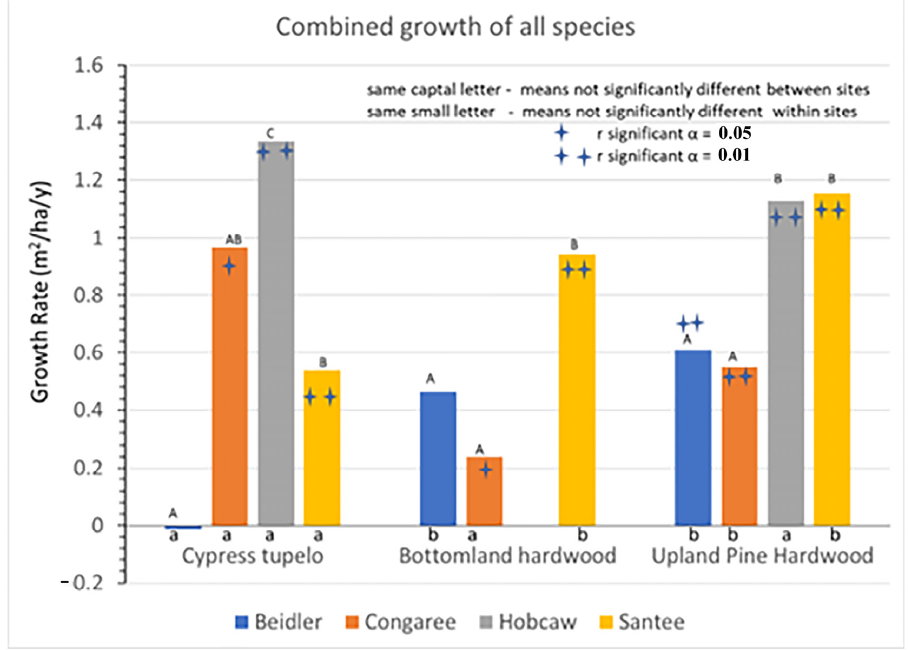
Figure 4. Overall growth rates of all species at each site for each vegetation